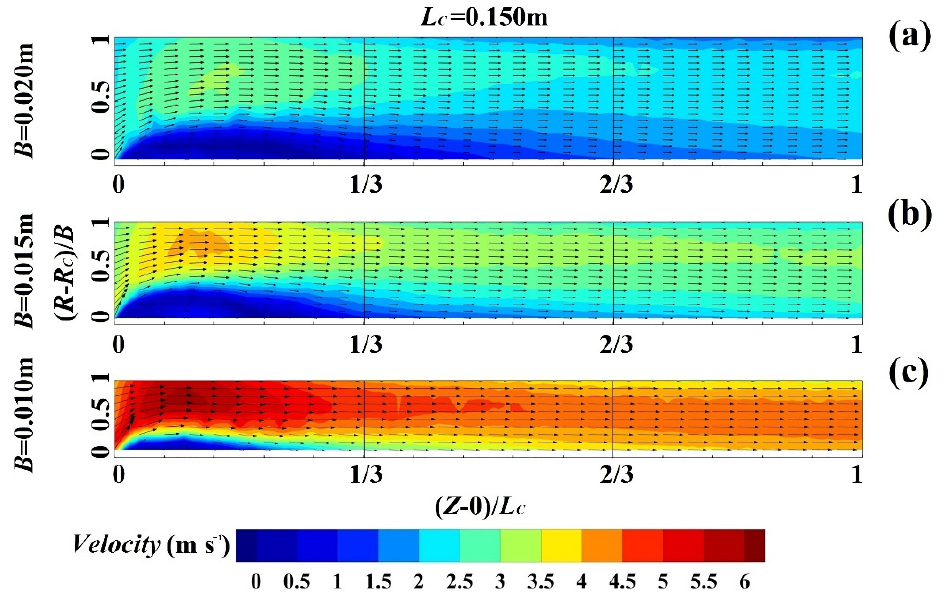
Figure 2. Averaged velocity of a meridian section under flow Q = 40 (m 3 h − 1 ): ( a ) contour for the gap width B = 20 × 10 − 3 m, η = 0.8; ( b ) contour for the gap width B = 15 × 10 − 3 m, η = 0.7; ( c ) contour for the gap width B = 10 × 10 − 3 m, η = 0.6. The contours show the velocity magnitude, and the arrows show the velocity direction.